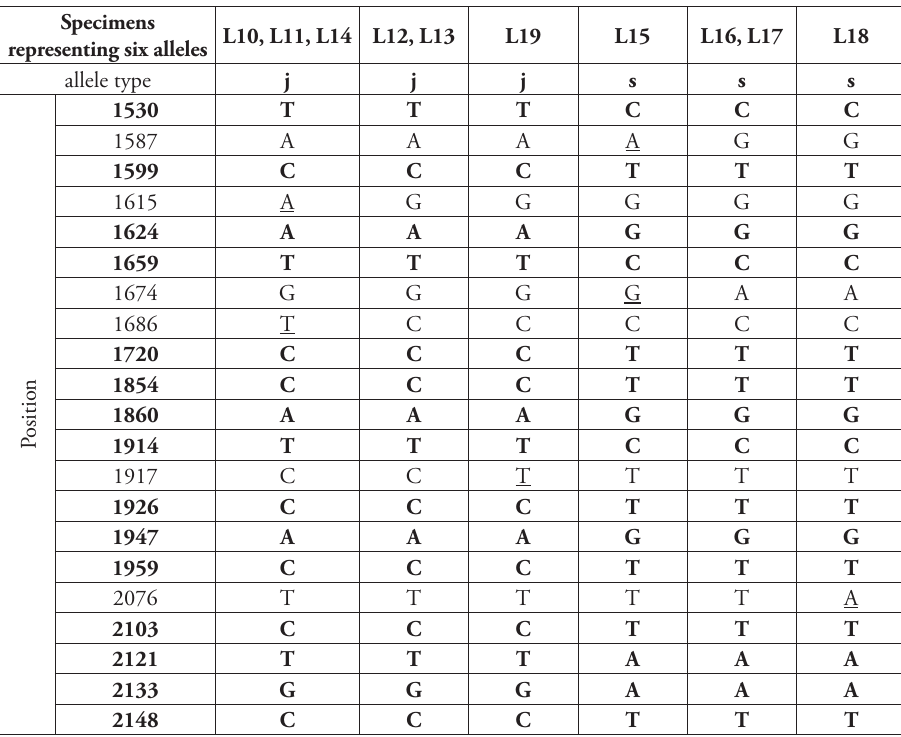
Table 2. Polymorphic positions in the COI gene in Leptidea sinapis (specimens L15-L18) and L. juver- nica (specimens L10–L14 and L19). Positions discriminating s - and j - allele types are boldfaced; intraspe- cific substitutions are